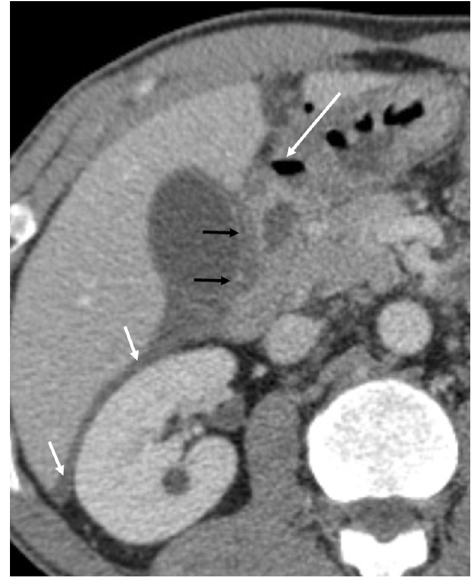
Fig. 10 A 48-year-old man who presented with abdominal pain caused by a perforated duodenal ulcer. Axial contrast-enhanced CT shows an irregular air-fluid level (large arrow) adjacent to the duodenal bulb. A leakage of free fluid into the posterior subhepatic space (white arrows) through hepatoduodenal ligament (black arrows) is